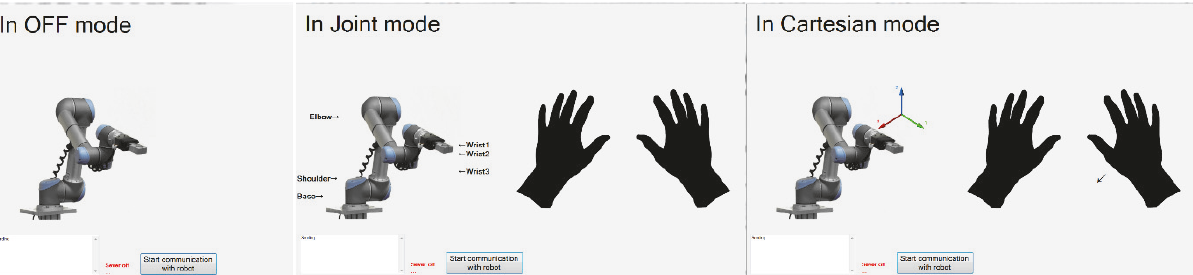
Figure 5: User interface in different modes.